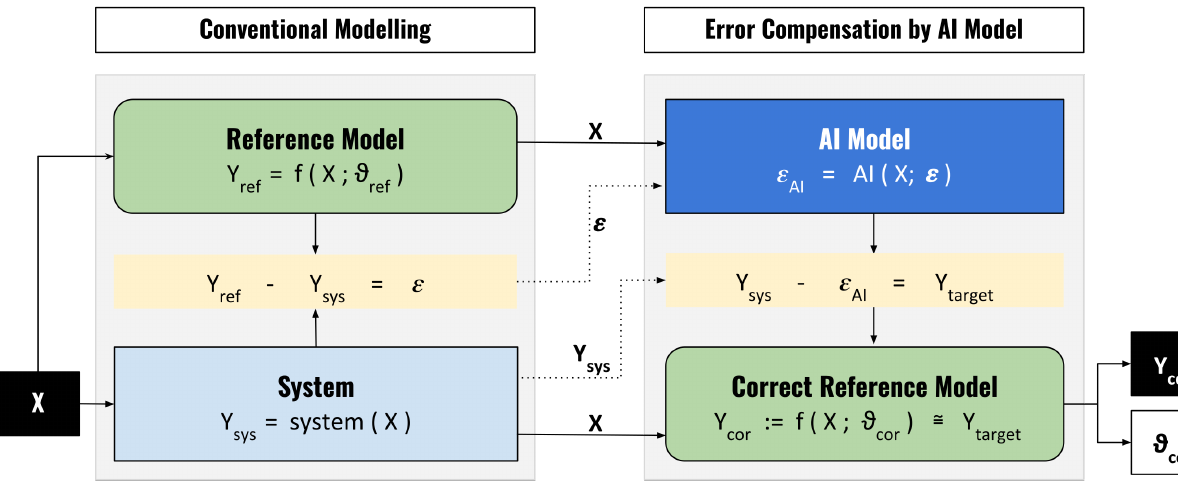
Figure 6. Schema of Before and After Correction Parameter Comparison (BAPC) [124]. Left: Reference Model produces prediction Y ref by means of parameter ϑ ref due to some conventional parameter identification method; Right: An AI Model is trained on ( X i , ε i ) to compensate for the residuum of the reference model. The interpretation of the AI Model can be i grounded on the meaning of the parameter of the reference